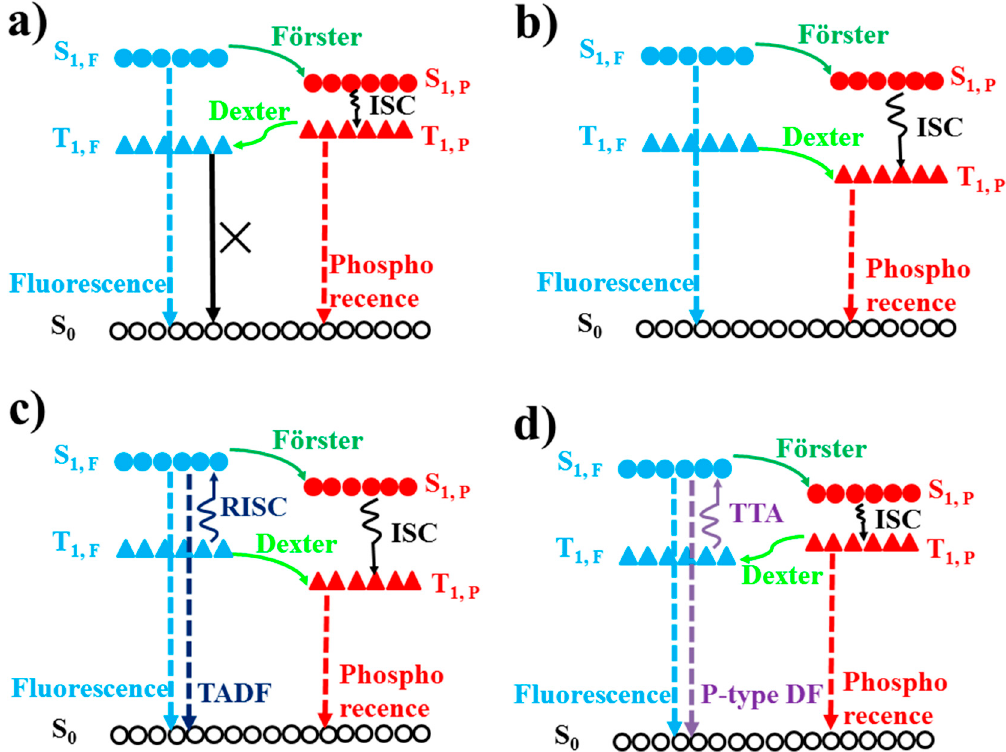
Figure 17. Emission mechanisms for different hybrid WOLEDs and the possible methods of decay of singlet and triplet excitons. ( a ) Hybrid WOLEDs with low-T 1 blue fluorophores; ( b ) Hybrid WOLEDs with high-T 1 blue fluorophores; ( c ) Hybrid WOLEDs with TADF blue fluorophores; ( d ) Hybrid WOLEDs with p-type blue fluorophores. S 1,F and T 1,F represent the singlet and triplet energy of fluorophores, respectively. S 1,P and T 1,P represent the singlet and triplet energy of phosphors, respectively. S 0 represents the ground state. DF is delayed fluorescence. Förster and Dexter represent the Förster and Dexter energy transfer between fluorophores and phosphors, respectively.